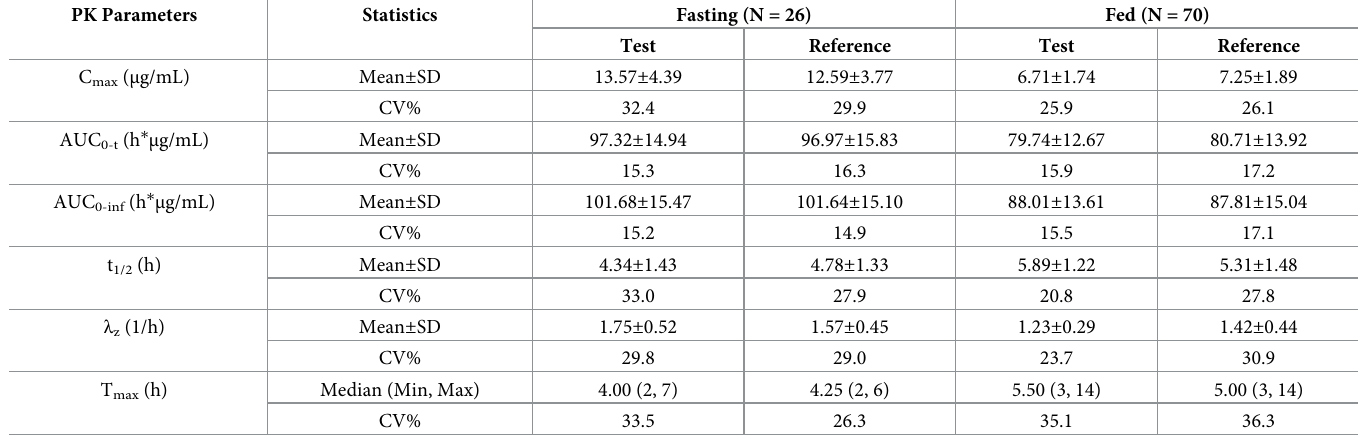
Table 3. Pharmacokinetic properties of test and reference products of calcium dobesilate capsules after single-dose oral administration in healthy Chinese volun- teers under fasting and fed conditions. PK